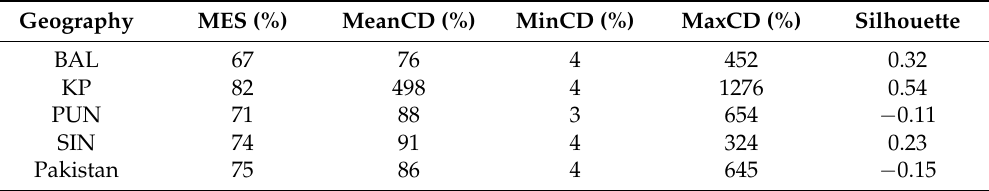
Performance of CLOPE for Event–Target clustering (countrywide and provincially); MES = mean element similarity (%), MeanCD = mean cluster distance (%), MinCD = minimum cluster distance (%), MaxCD = maximum cluster distance (%).